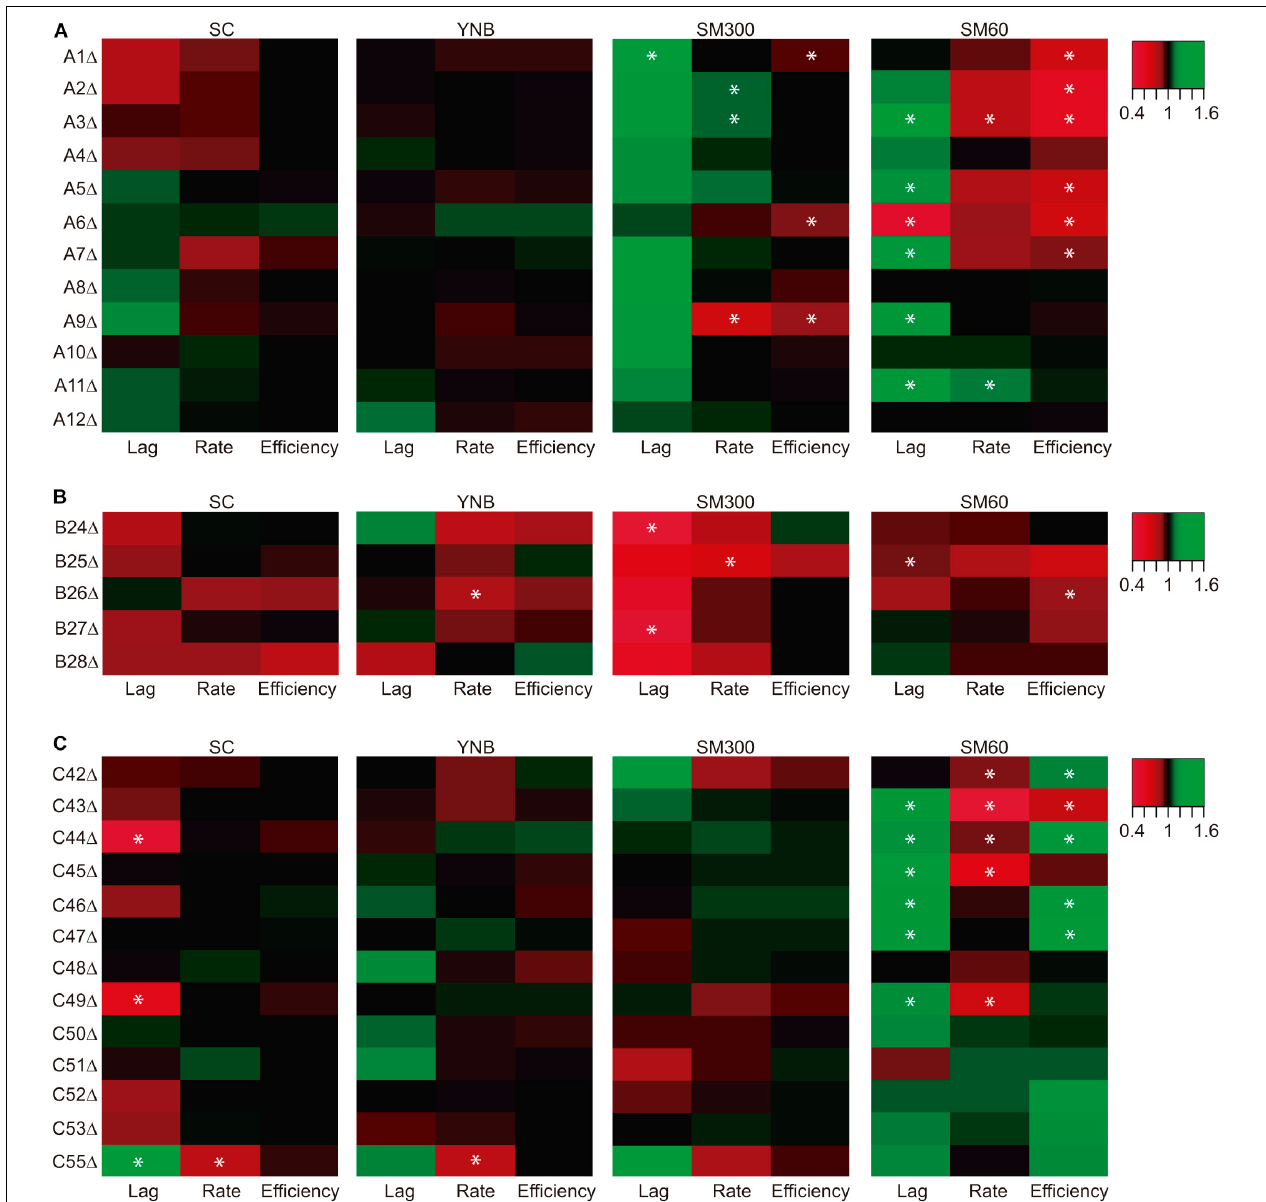
FIGURE 4 | Kinetic parameters for strains carrying deletions in horizontally acquired genes. The strains carrying deletions in different horizontally acquired genes inside region A (A) , region B (B) , and region C (C) were grown in four culture conditions (SC, YNB, SM300, and SM60). The kinetic parameters were extracted from the growth curves for the phenotypic comparison of latency time (Lag), growth rate (Rate) and growth efficiency (Efficiency). The normalized phenotypic values are represented as a heat map where the wild type phenotype has a value equal to 1 in the color scale, and red and green represent lower and higher values of the phenotypes respect to the wild type strain, respectively. Asterisks represent a statistically significant difference between the phenotype of the strain carrying the deletion and its wild type version ( t -test, p < 0.05). The heat map was constructed with the average values of three biological